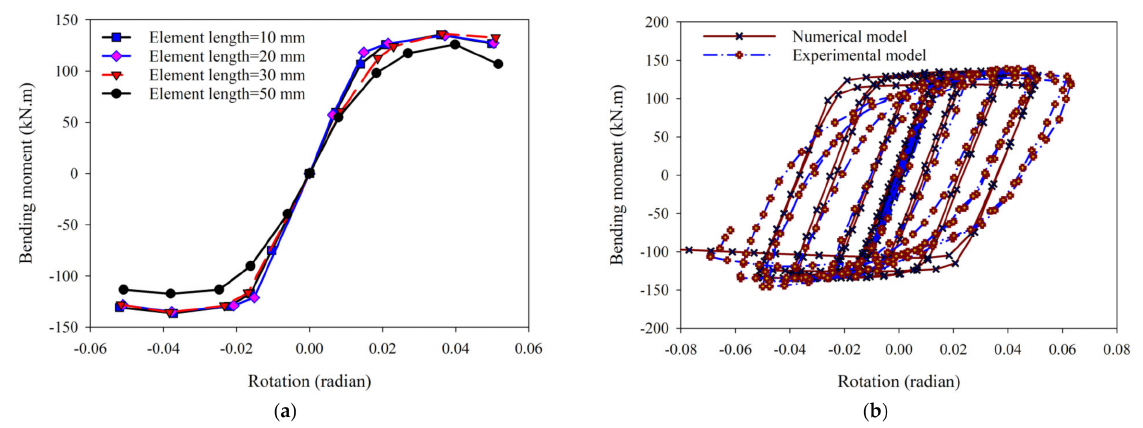
Figure 3. Load–displacement curves of the numerical model and the experimental specimen: ( a ) sensitivity analysis and ( b ) bending moment-rotation curves.